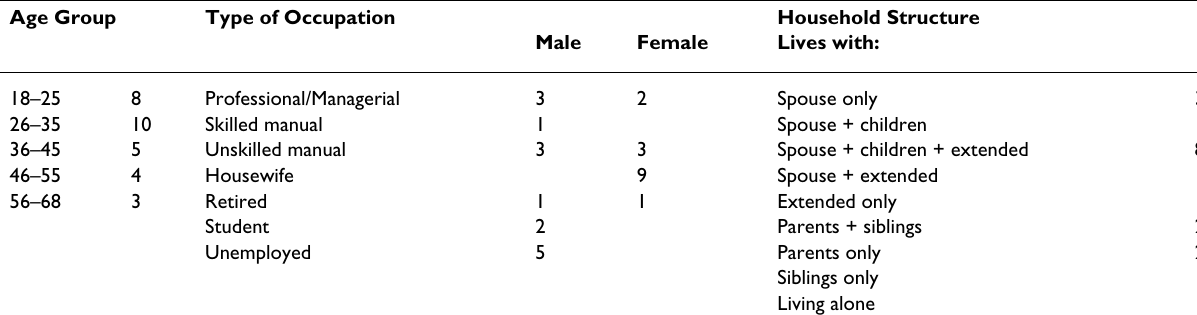
Table 3: Details of the 30 people with epilepsy included in the study